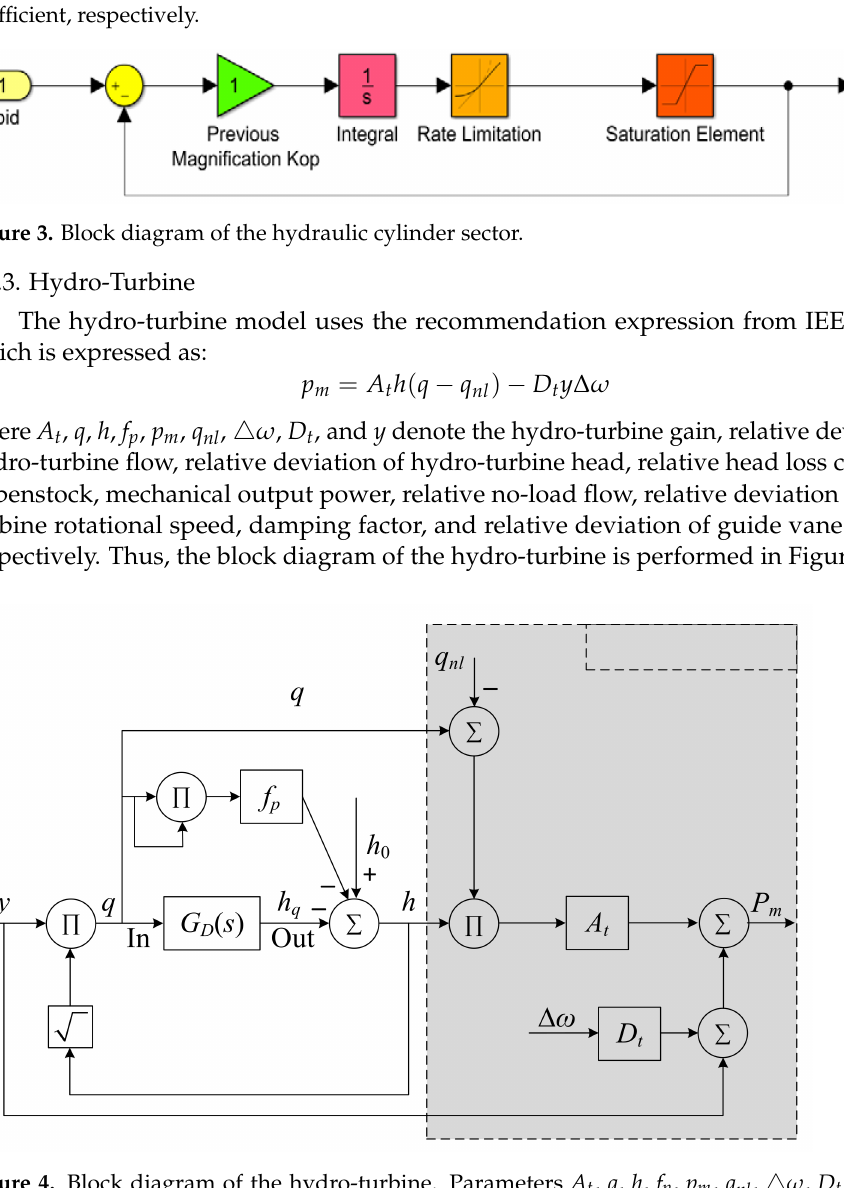
Figure 4. Block diagram of the hydro-turbine. Parameters A t , q , h , f p , p m , q nl , (cid:52) ω , D t , y h fc and h q denote the hydro-turbine gain, relative deviation of hydro-turbine flow, relative deviation of hydro-turbine head, relative head loss coefficient in penstock, mechanical output power, relative no-load flow, relative deviation of hydro-turbine rotational speed, damping factor, relative deviation of guide vane opening, relative head friction loss and hydro-turbine head change caused by flow,